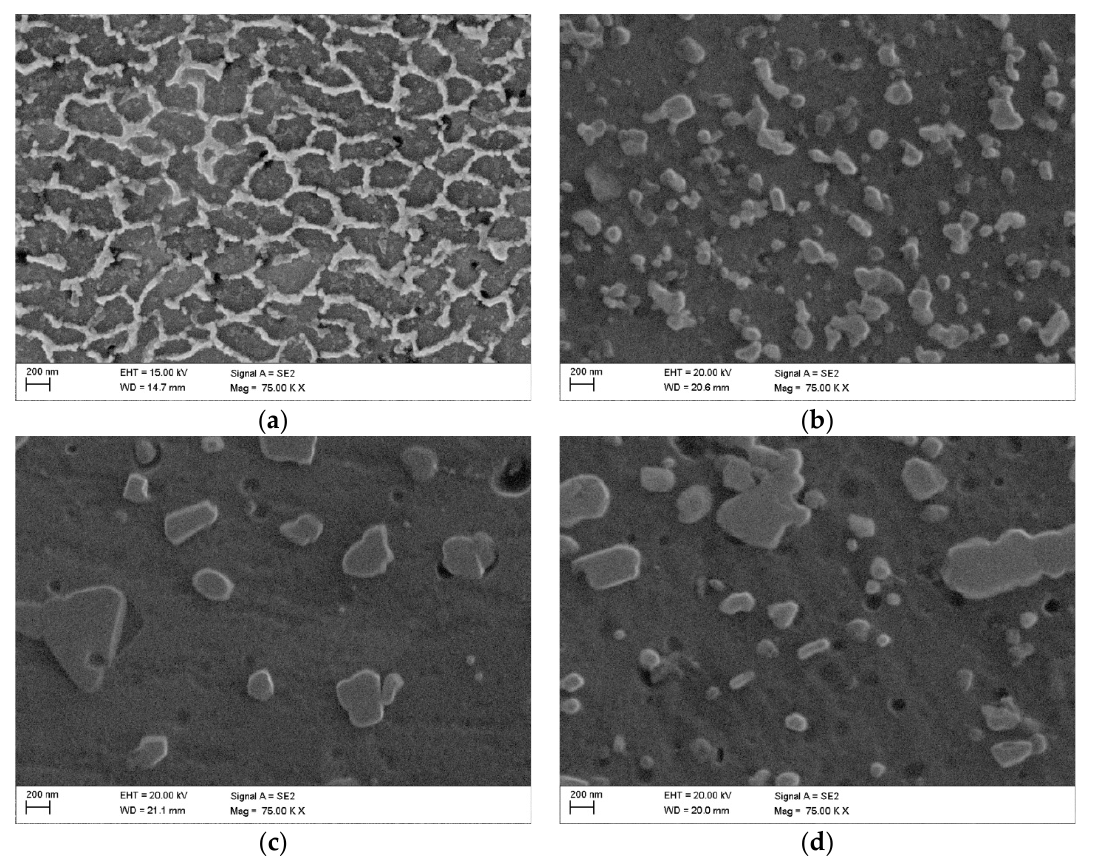
Figure 6. SEM images of ECAP ‐ processed samples ( a ) HT280E150; ( b ) SLME350; ( c ) SLME400; ( d ) SLME450.